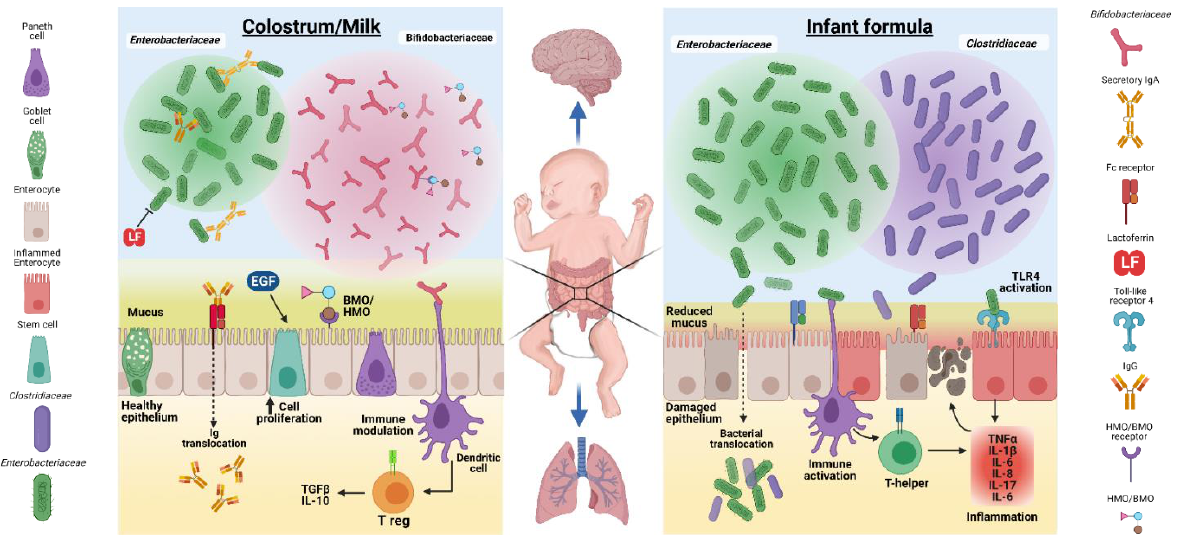
Figure 4. Possible differences between effects of maternal colostrum/milk and formula on the neonatal gut. The figure illustrates some of the proposed functional effects of maternal colostrum/milk bioactive factors on the dominant gut microbiota communities, mucosal epithelium, and immune cells, relative to formula diets. Enterobacteriaceae , Bifidobacteraceae , and Clostridiaceae families represent common bacteria groups found in the developing neonatal gut. The bacterial community composition can be affected by maternal milk factors, such as Igs (IgA and IgG), LF, bovine and human oligosaccharides (BMO/HMO), and a number of growth factors (e.g., EGF). Igs and LF have antimicrobial properties that function to limit epithelial inflammation and apoptosis resulting from activation of Toll-like receptor 4 (TLR4) by Enterobacteriaceae . BMO/HMO may serve as a substrate for growth and colonization of Bifidobacteraceae , a family of bacteria associated with gut health. The figure also illustrates that key peripheral organs, including the brain and lungs, directly or indirectly may be impacted by colostrum/milk-induced improved gut microbial activity and gut mucosal immune defense. (Created with BioRender.com; accessed on 7 June 2021.)